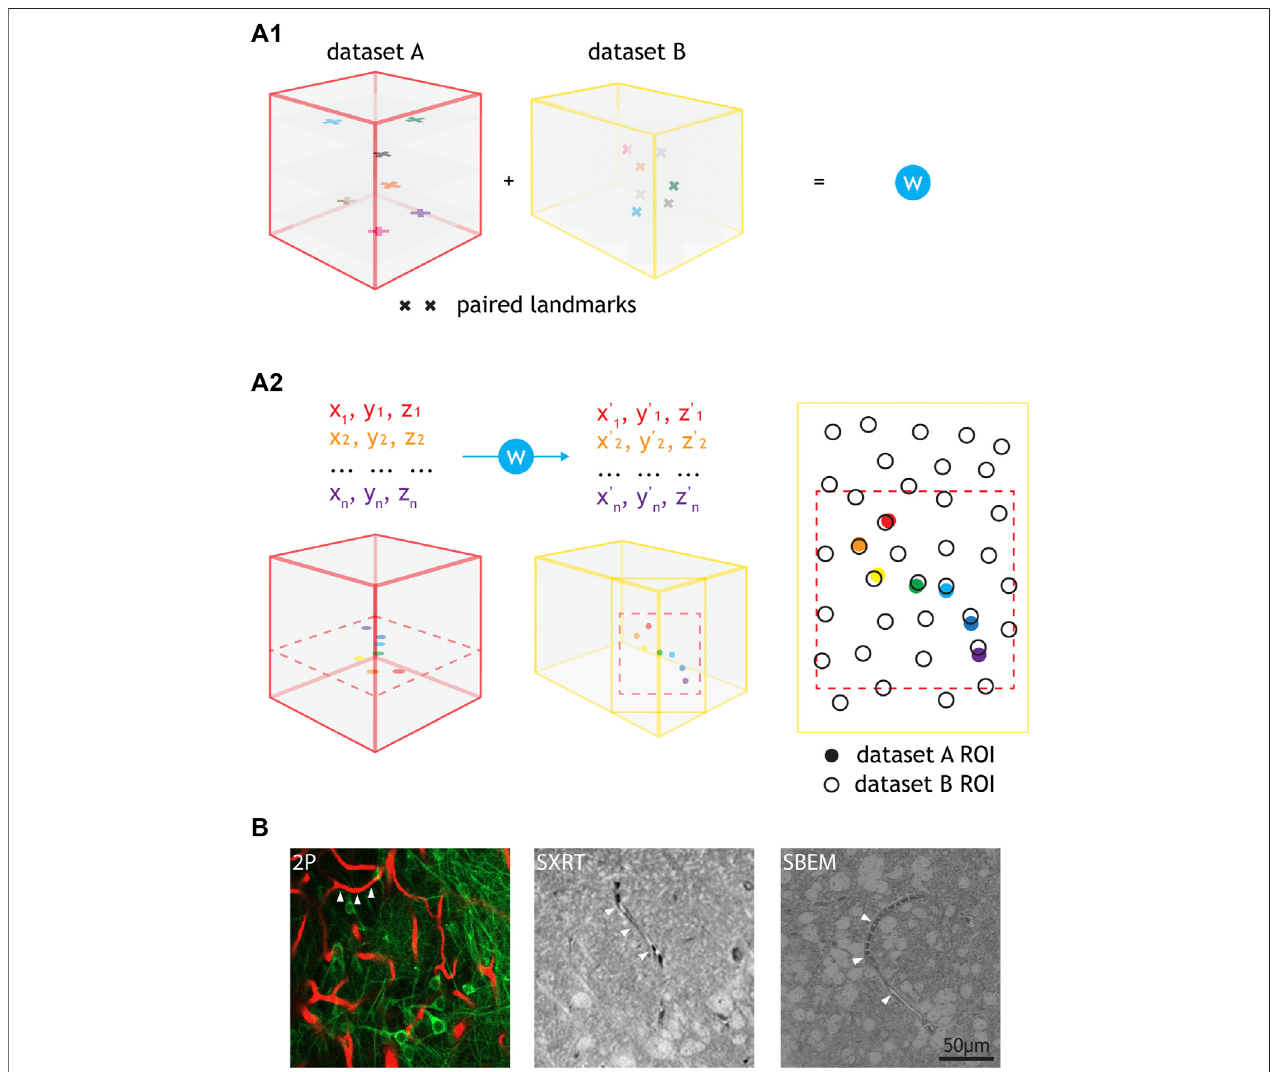
FIGURE5| Warpingusingcommonfeaturese.g.,bloodvesselsandcellcorrelationbyannotationwarping. (A1) Commonfeaturesfoundthroughoutthevolumeof two datasets (i.e., paired landmarks) are used tocalculatea warping function ( “ W ” ). (A2) The warping function can be used towarp any annotations from one dataset to another.Theinputsneededarethex,y,zcoordinatesoftheannotationsinthenativedatasetspaceandtheoutputsarethex,y,zcoordinatesofthoseannotationsinthe target dataset space. Annotation warping is used to correlate ROIs from two datasets. ROIs can be correlated as long as the warped ROI falls to a position that is closer tothetargetROIthan any other ROI. For (A1,A2) ,cubes representdatasets (e.g.,2P, LXRT,SXRT, SBEM), acquired from thesamepiece oftissue.Thedatasets may differ in the dimensions, voxel sizes and the exact region of the sample, differences here represented by cube dimensions, landmark sizes and landmark positions, respectively. Other differences may involve a reversed order in one of the spatial dimensions (such as an horizontal fl ip in all images), making it necessary to use chiral structures as a source for warping landmarks. (B) Example images showing different blood vessels (arrowheads) resolved by 2P, SXRT and EM datasets.